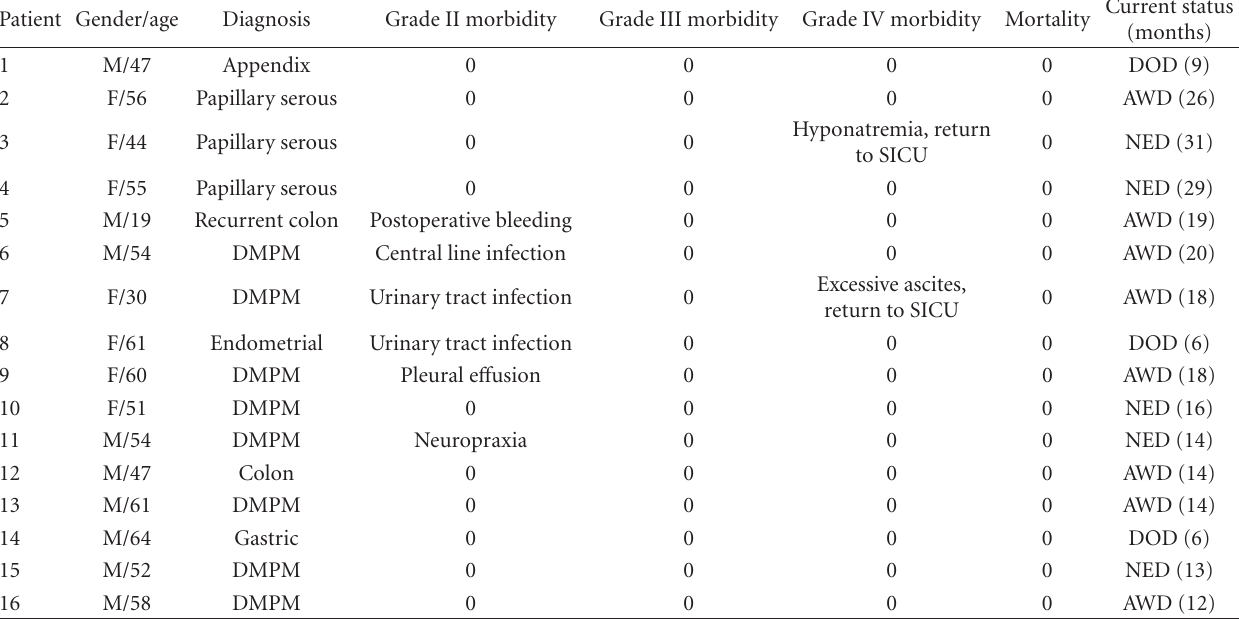
Table 2: Clinical features and prospective morbidity-mortality assessment of 16 patients with peritoneal surface malignancy having cytore- ductive surgery and perioperative hyperthermic